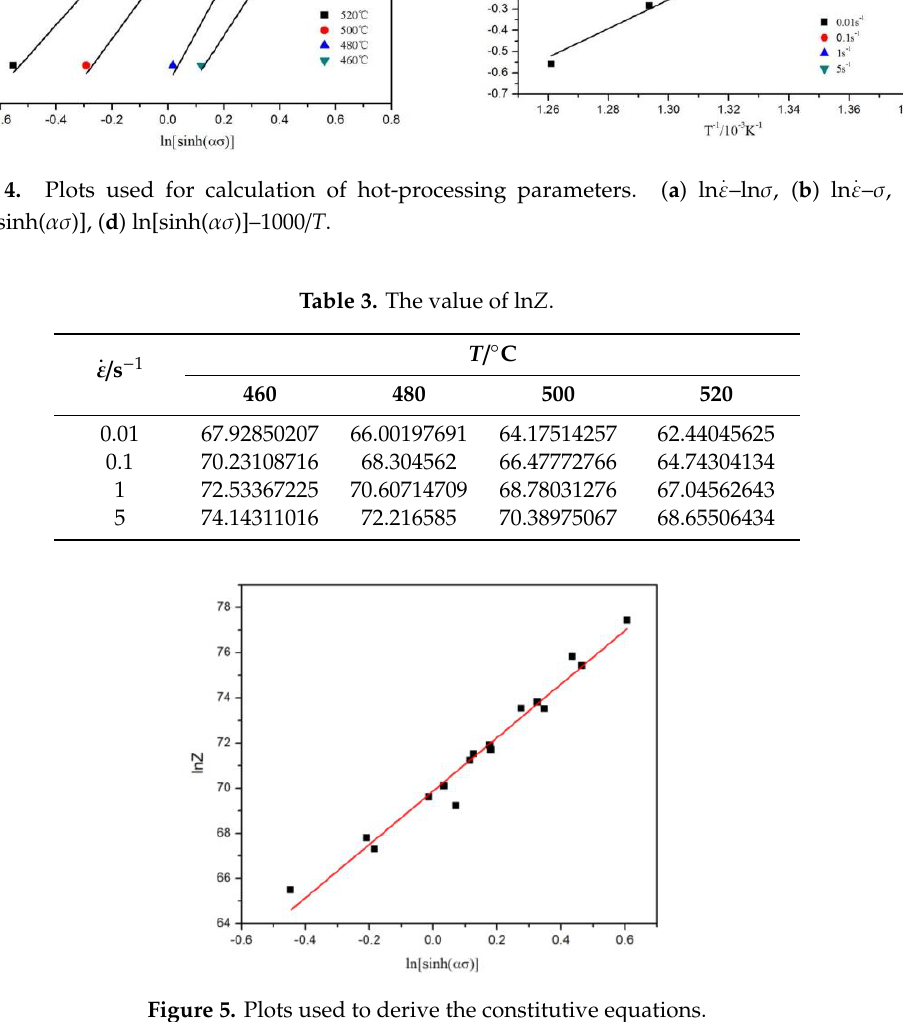
Figure 4. Plots used for calculation of hot-processing parameters. ( a ) ln   –lnσ, ( b ) ln   –σ, ( c ) ln   –